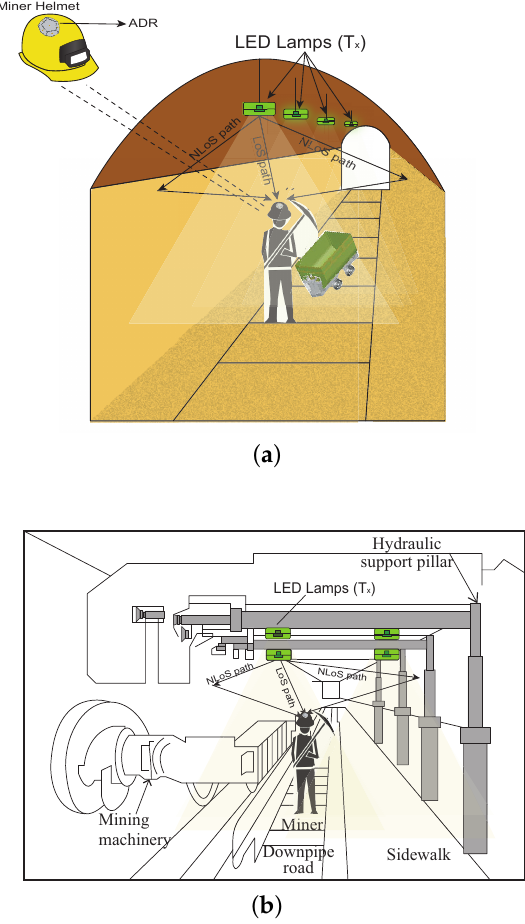
Figure 1. Underground mining VLC System Model. ( a ) Scheme of the mining roadway environment with the LED lamps row location and ( b ) scheme of the mine working face with the quadrature location of the LED lamps.